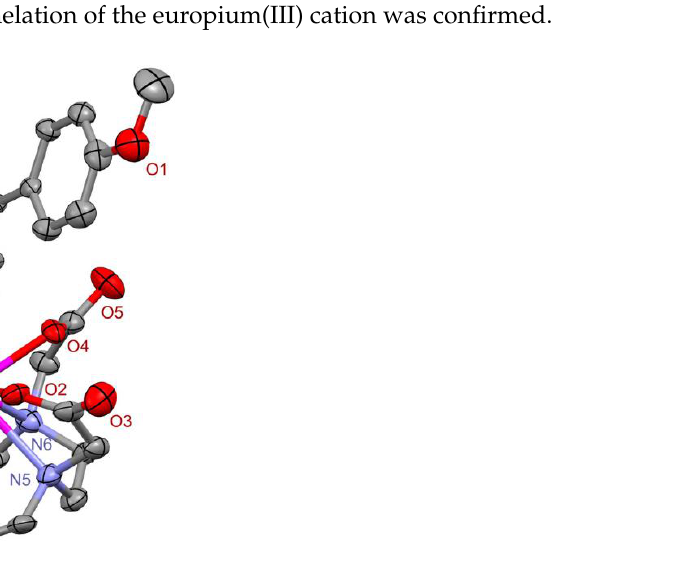
Table 1. Photophysical properties of new complexes of Ln•4,5,10 and previously published similar complexes.